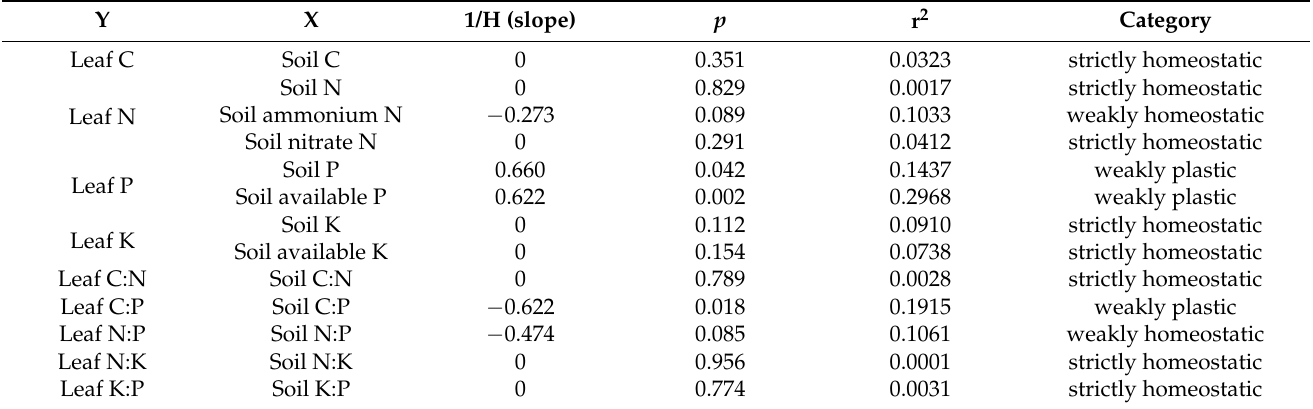
Table 3. Standardized major axis regression analysis and stoichiometric homeostasis